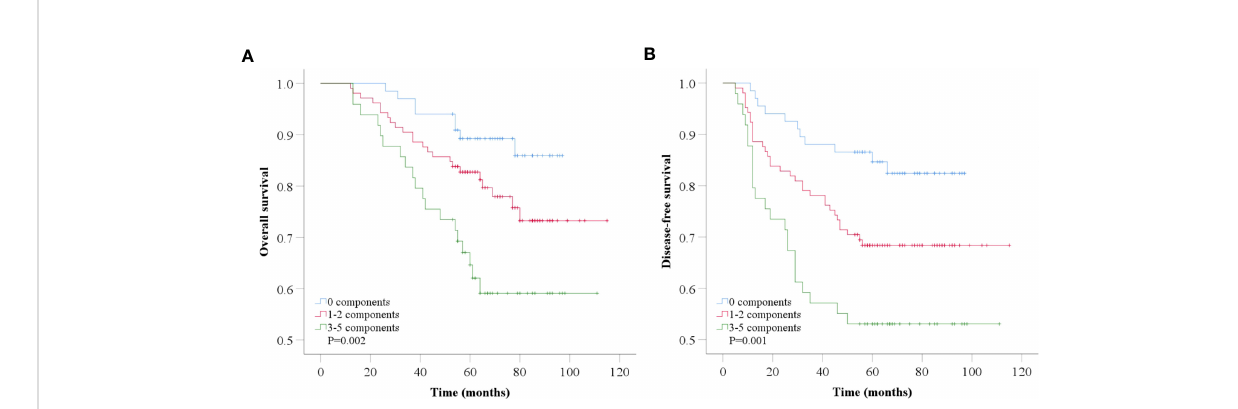
FIGURE 4 Kaplan-Meier analysis of overall survival (A) and disease-free survival (B) according to number of MetS